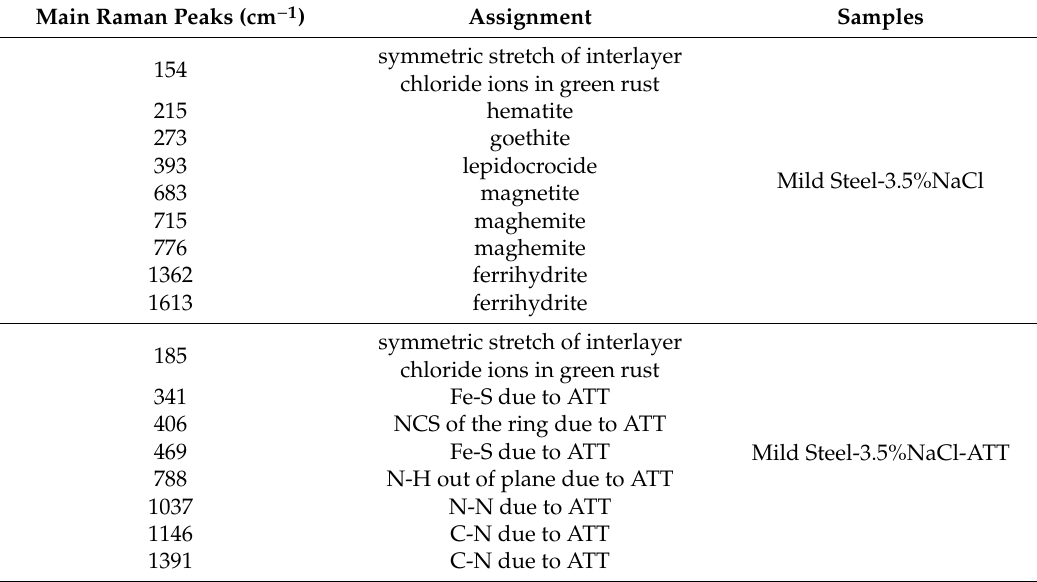
Figure 8. Raman spectra of mild steel immersed into 3.5 wt.% NaCl for 144 h: ( a ) Mild Steel-3.5%NaCl, ( b ) Mild Steel-3.5%NaCl-ATT. Table 4. Classification of the Raman spectra